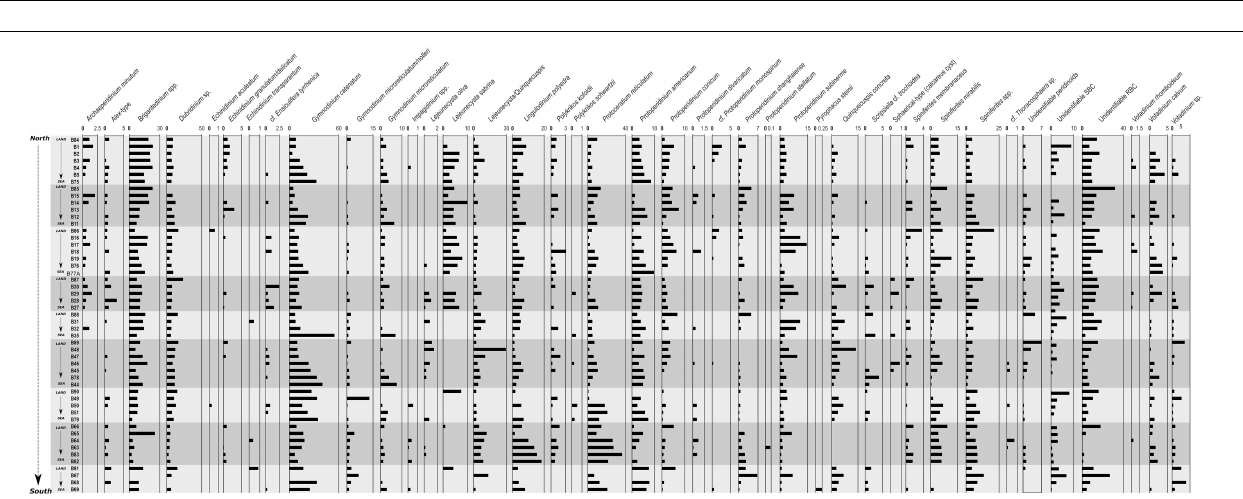
FIGURE 5 | Spatial distribution of relative abundances (%) of autotrophic (A) and heterotrophic (B) cyst taxa.